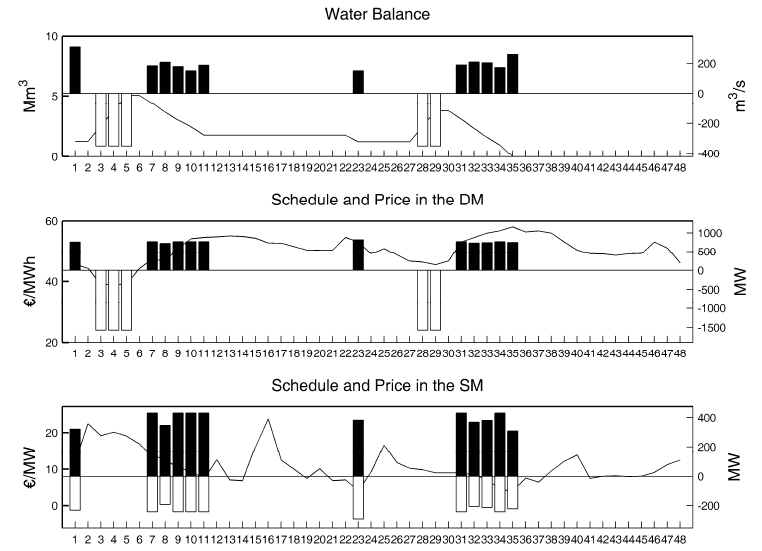
Figure 12. Optimal operation of the 4 h PSHP with the DM D + 1 strategy on 2–3 June 2014.